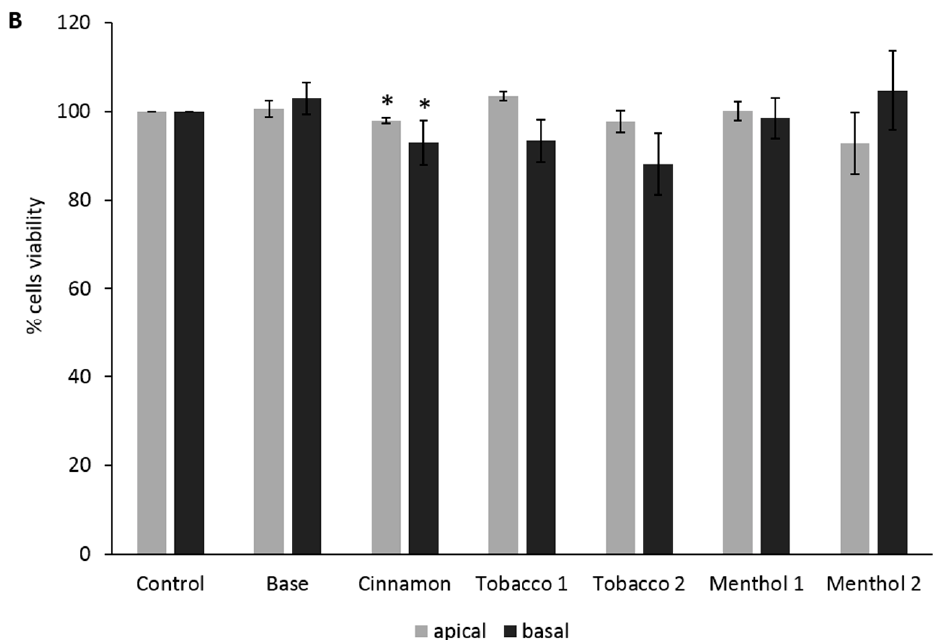
Figure 4. Barrier integrity and cell viability in the in vitro alveolar-blood barrier (ABB) model exposed to CAs from different e-liquids with 18 mg/mL nicotine. ( A ) trans-epithelial electrical resistance (% TEER day13/day12) measured across the barrier; ( B ) cells viability percentage measured in the alveolar NCI-H441 cells (apical, grey histograms ) and in the endothelial HPMEC cells (basal, black histograms ). Data are presented as mean ± SEM of at least three different independent experiments. * p < 0.05; unpaired t -test over the control (untreated cells); § p < 0.05; unpaired t -test over Base 18.